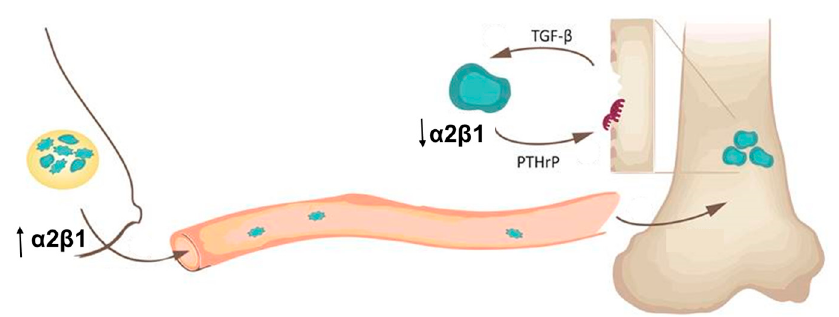
Figure 6. α 2 β 1 integrin expression in primary breast tumors promotes tumor growth, invasion, and dissemination to the bone. However, once established in the bone, α 2 β 1 expression is lost and tumors begin to express genes, such as Gli2 and PTHrP, that promote tumor-induced bone destruction.